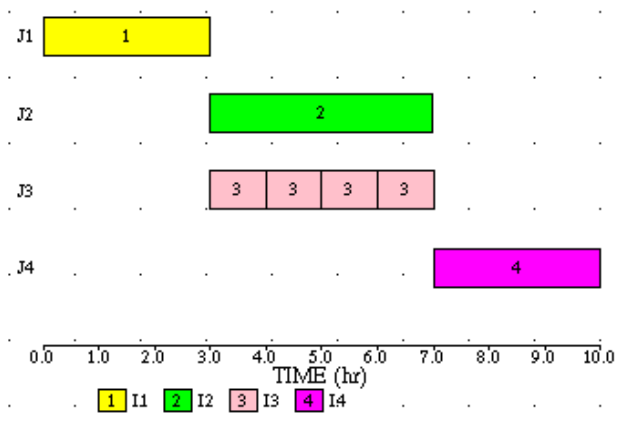
Figure 5. Example 1 Gantt chart.